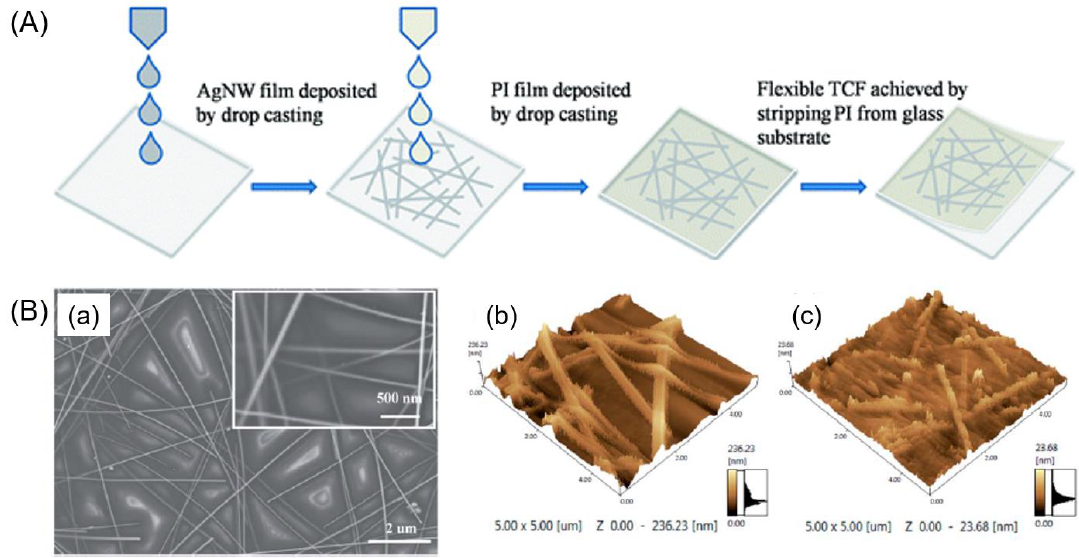
Figure 2. ( A ) Fabrication of a flexible polymer solar cell (PSC) based on a PI/Ag NW composite film. ( B ) ( a ) SEM images of a flexible PI / Ag NW composite film. AFM height images of ( b ) glass / Ag NWs ( B ) ( a ) SEM images of a flexible PI/Ag NW composite film. AFM height images of ( b ) glass/Ag NWs and ( c ) PI / Ag NW composite film. Reproduced with permission from [11]. Copyright 2015 and ( c ) PI/Ag NW composite film. Reproduced with permission from [11]. Copyright 2015 Royal Society of Chemistry.